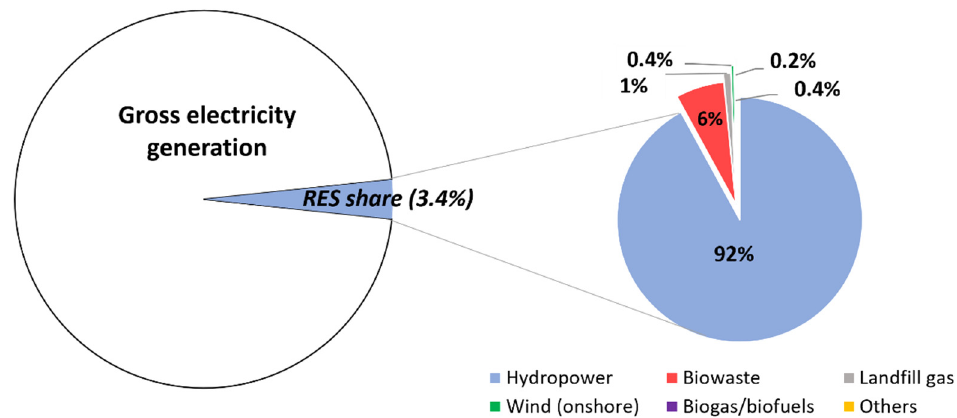
Figure 1. Shares of renewable power sources in gross electricity generation, 1990. Source: Own elaboration. Data from